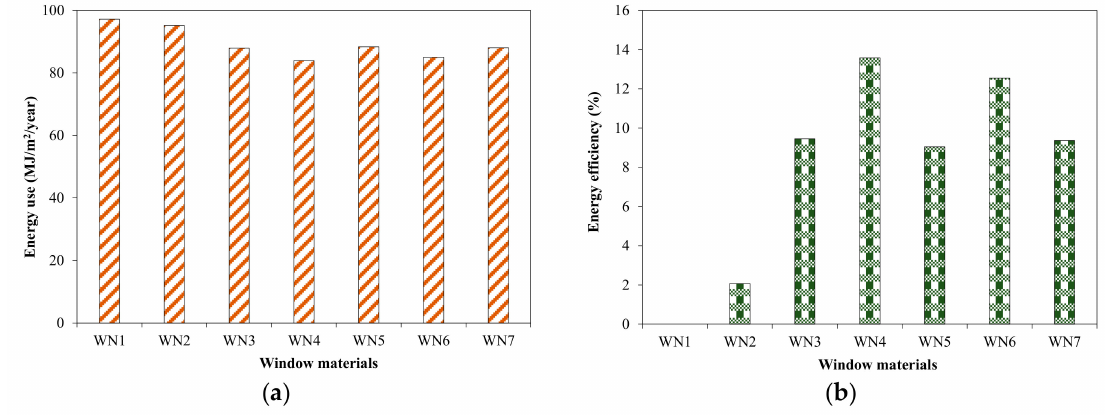
Figure 7. Effect of window material on energy use in tested house building. ( a ) Energy use; ( b )